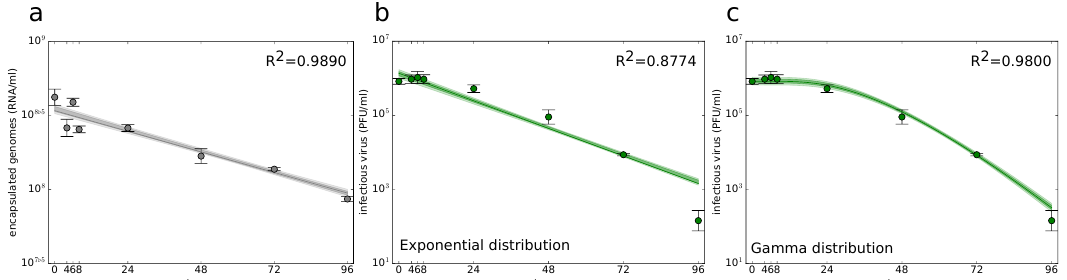
Figure 1. Time course decay of Zika virus (ZIKV) in the physical conditions of the in vitro kinetic experiments. Decay of ( a ) encapsulated genomes and ( b , c ) infectious virus described by ( b ) exponential distribution decay model (2) with n pfu = 1 and ( c ) gamma distribution decay model (2) with standard deviation. The best-fits are displayed as solid n pfu = 8. Data are shown as the mean ± green lines. The light shading around the best-fits corresponds to the model kinetics associated with MCMC-accepted parameters. The dark shading represents 95% credible